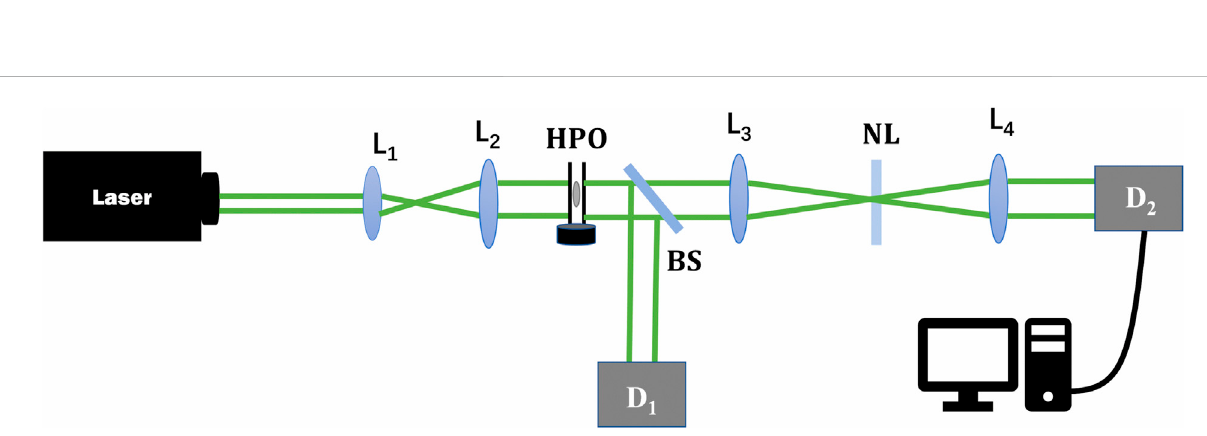
FIGURE 2 Schematicof4fimagingsystemwithHPO.L 1 -L 4 ,lenses;BS,beamsplitter;D 1 isusedtodetectthereferencelight,D 2 isusedtodetectthelinearand non-linear images.